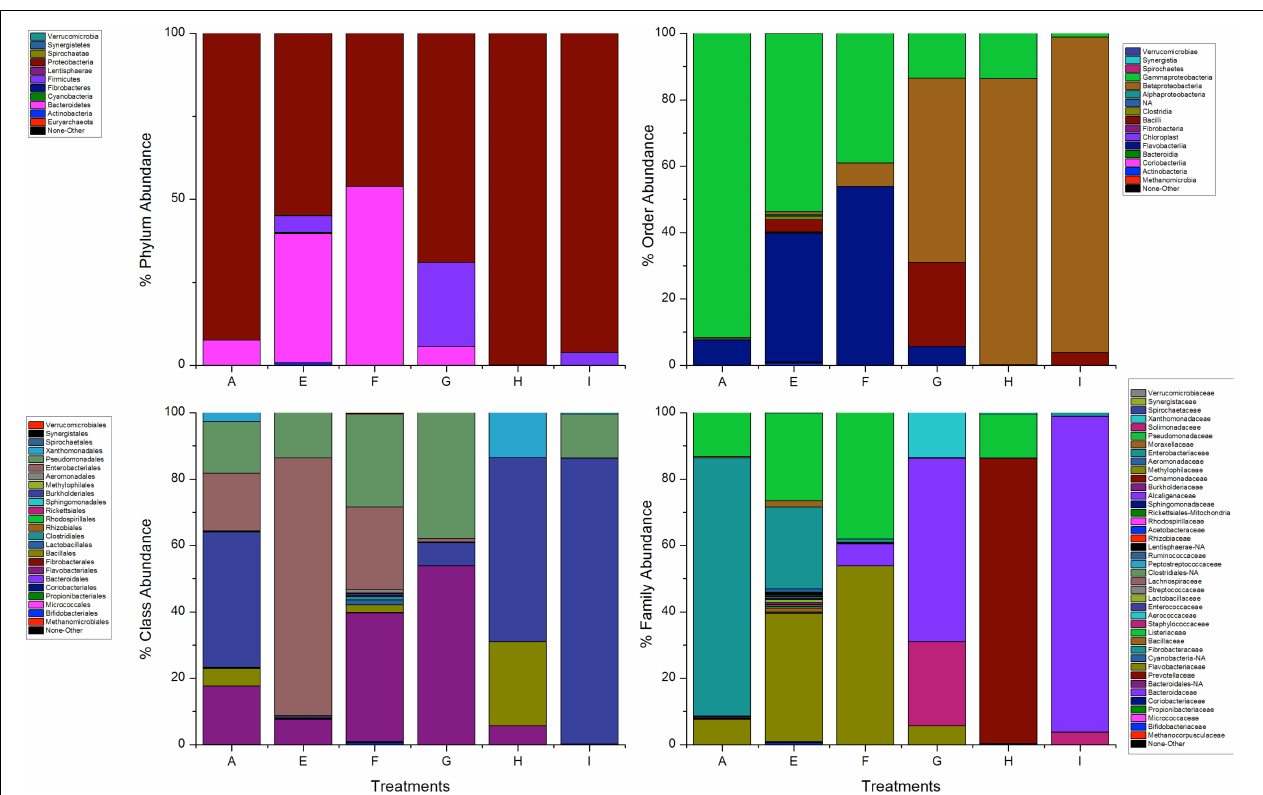
FIGURE 6 | Taxonomic variation between groups of A. aegypti exposed to deltamethrin. A: fed with sucrose 10% E: exposed to deltamethrin (control group), F: treated with penicillin/streptomycin deltamethrin exposed, G: treated with gentamicin deltamethrin exposed, H: treated with penicillin/streptomycin (not exposed), I: treated with gentamicin (not